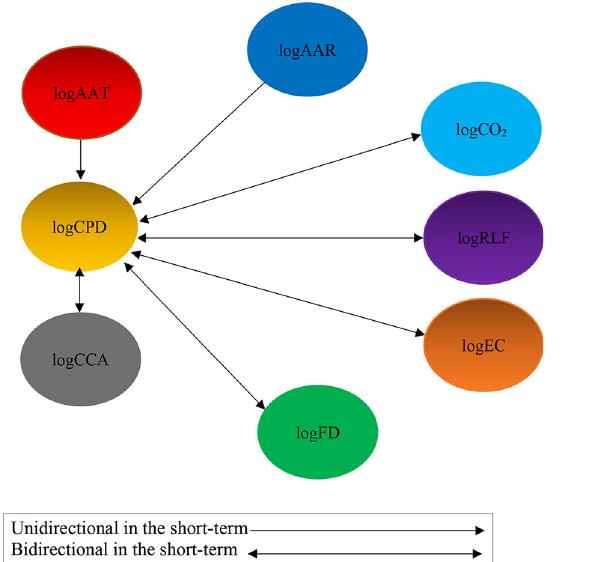
Figure 5. Short-term